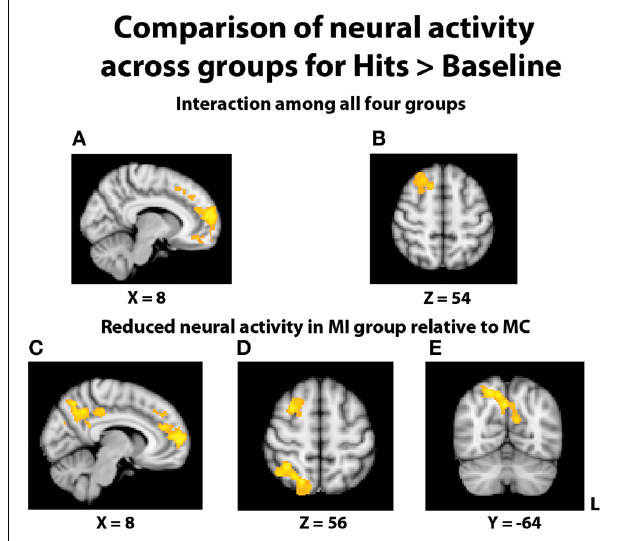
FIGURE 5 | Illustration of significant differential group activity for hits > baseline. (A,B) Significant activity for the interaction of age and TBI history, as measured by the contrast (YI + MC > YC + MI). Areas of significant activation included right medial prefrontal cortex and right superior frontal gyrus. (C–E) Reductions in neural activity for the MI group relative to the MC group were found in medial and lateral PFC, right superior parietal lobe, right posterior cingulate cortex, and bilateral precuneus. Coordinates are in MNI space; images are in radiological orientation (L =